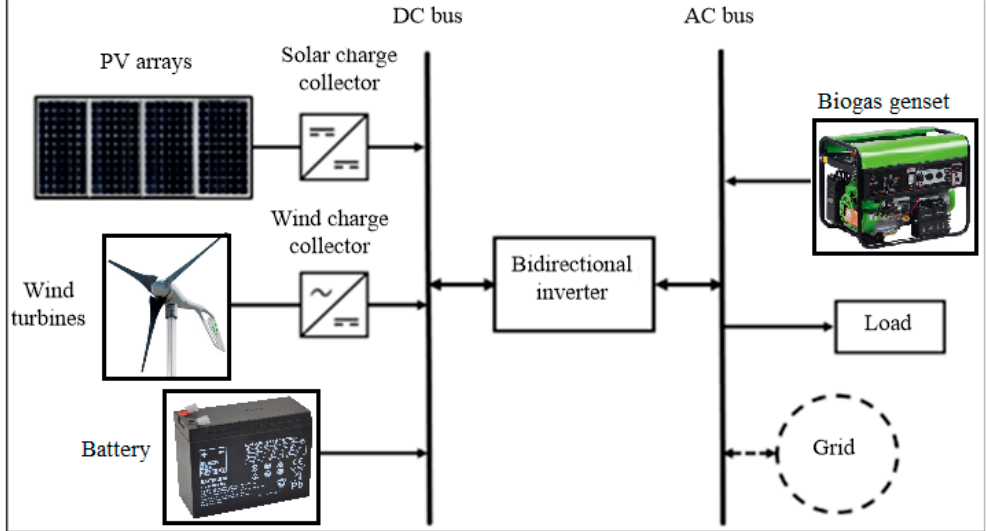
Figure 5. Design of the hybrid renewable energy system (HRES) applied to the house.